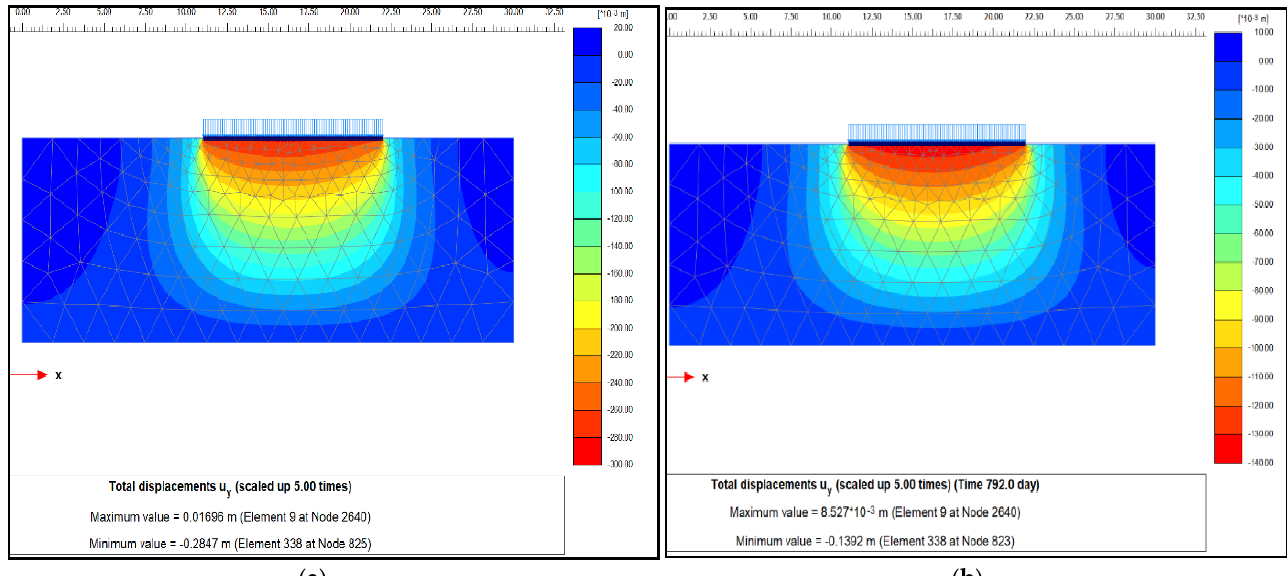
Figure 7. 400 kN/m 2 with ( a ) plastic analysis and ( b ) consolidation